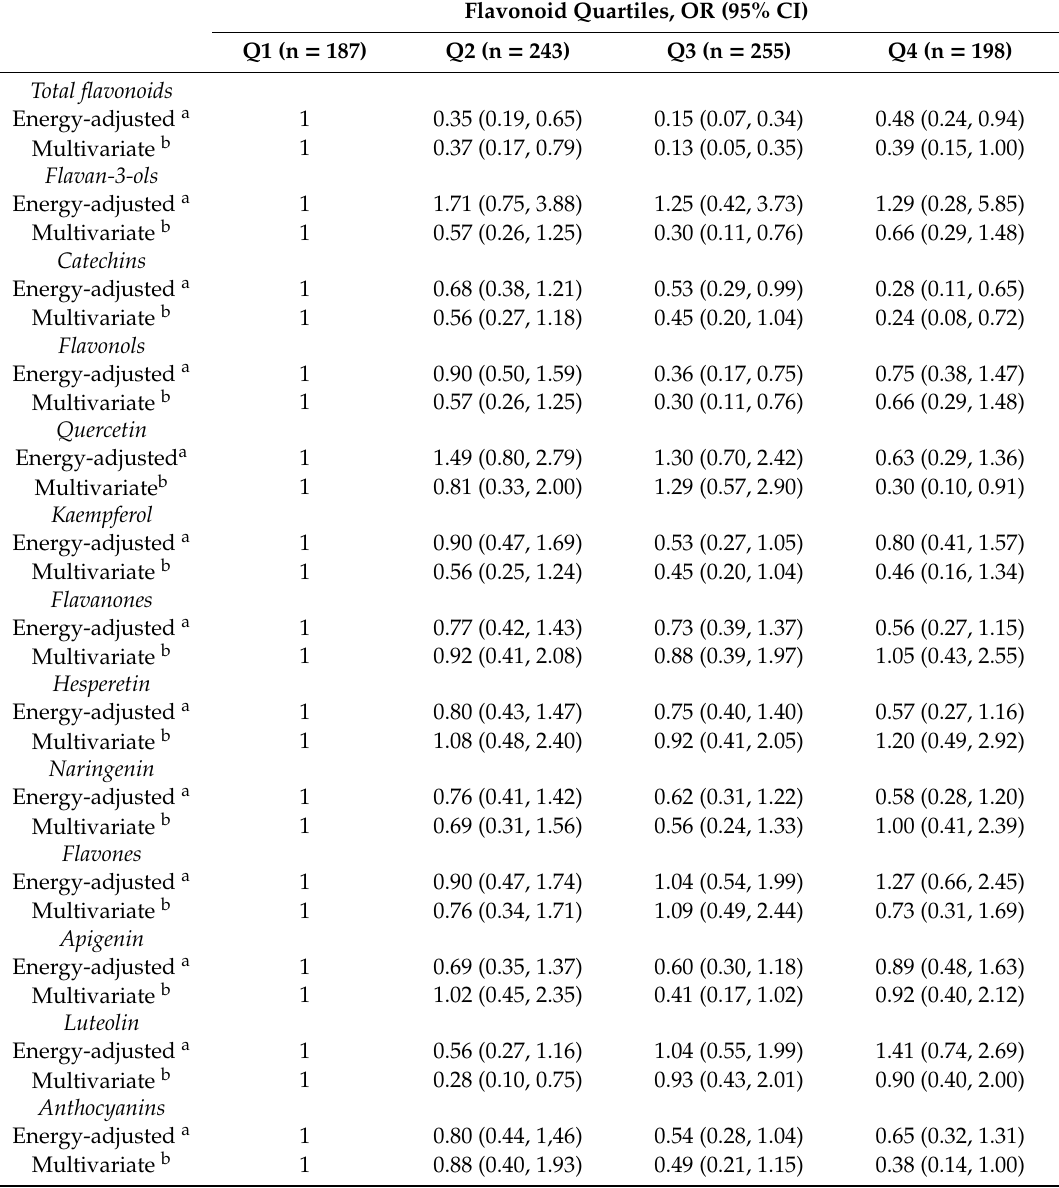
Table 3. Odds ratios (ORs) and 95% confidence intervals (CIs) for the association between flavonoid intake (total, classes and individual compounds) and impaired cognitive status in the MEAL